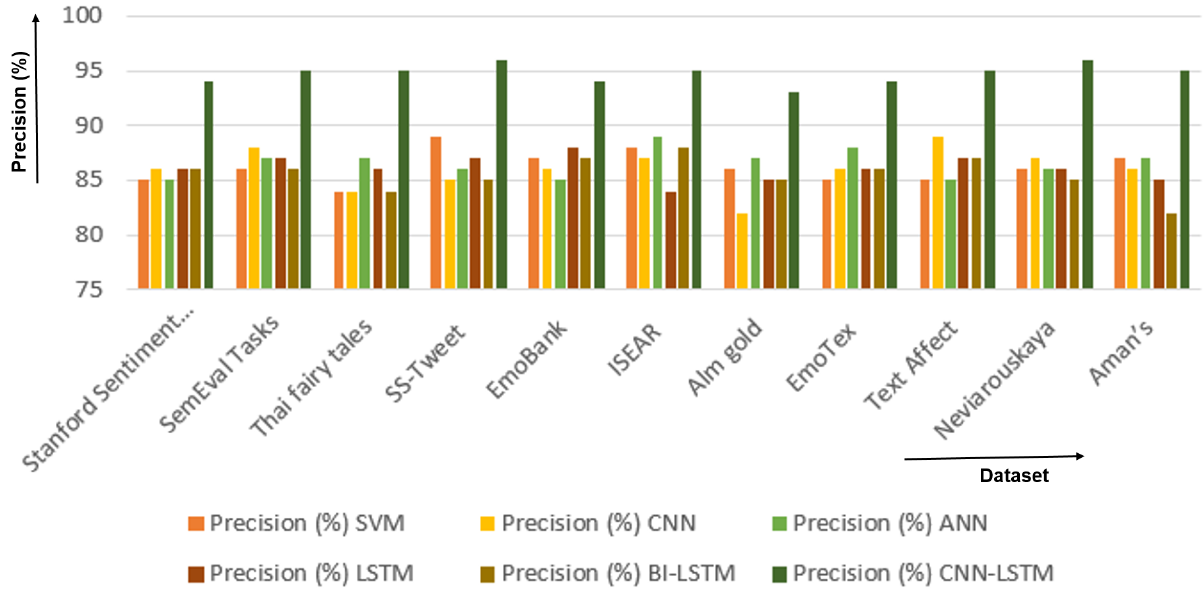
Figure 10. Performance analysis for BOW + IF-IDF with CNN-LSTM based on precision. (“Stanford Sentiment...” means “Stanford Sentiment